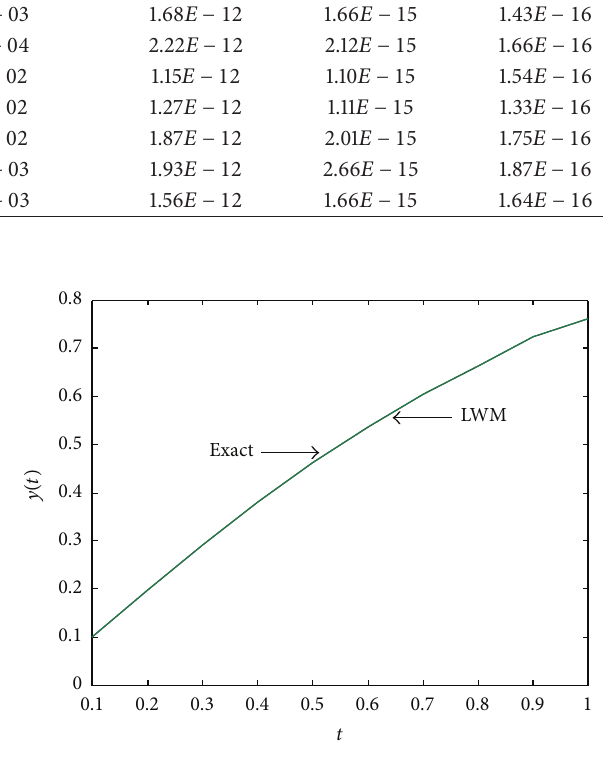
Figure 3: Numerical results of Example 2 by LWM for 𝛼 = 1